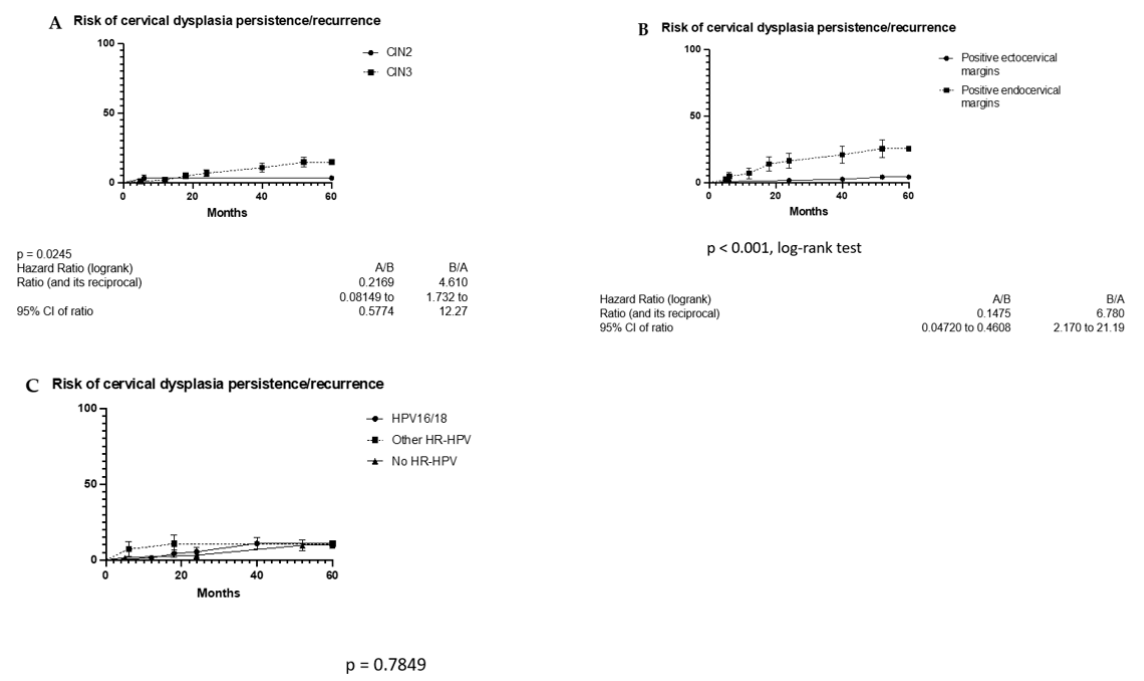
Figure 2. ( A ) Characteristics of patients with CIN2 and CIN3. ( B ) Characteristics of patients with positive ectocervical and endocervical margins. ( C ) Characteristics of the study population related to HPV infection type(s).